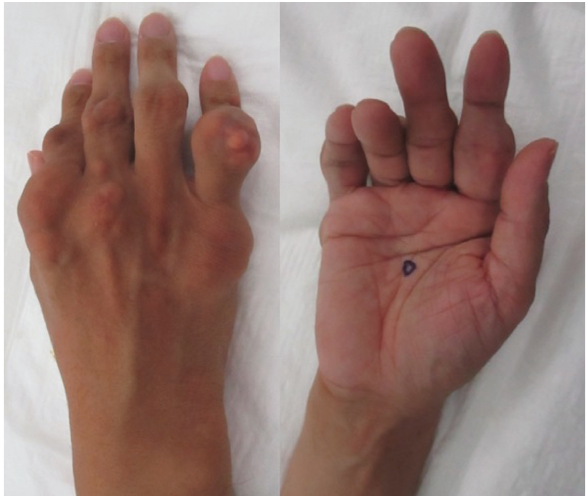
Figure 1: A photograph of the patient’s right hand. There were several subcutaneous nodules in the hand and digits. The index finger was not able to extend actively at the metacarpophalangeal joints.